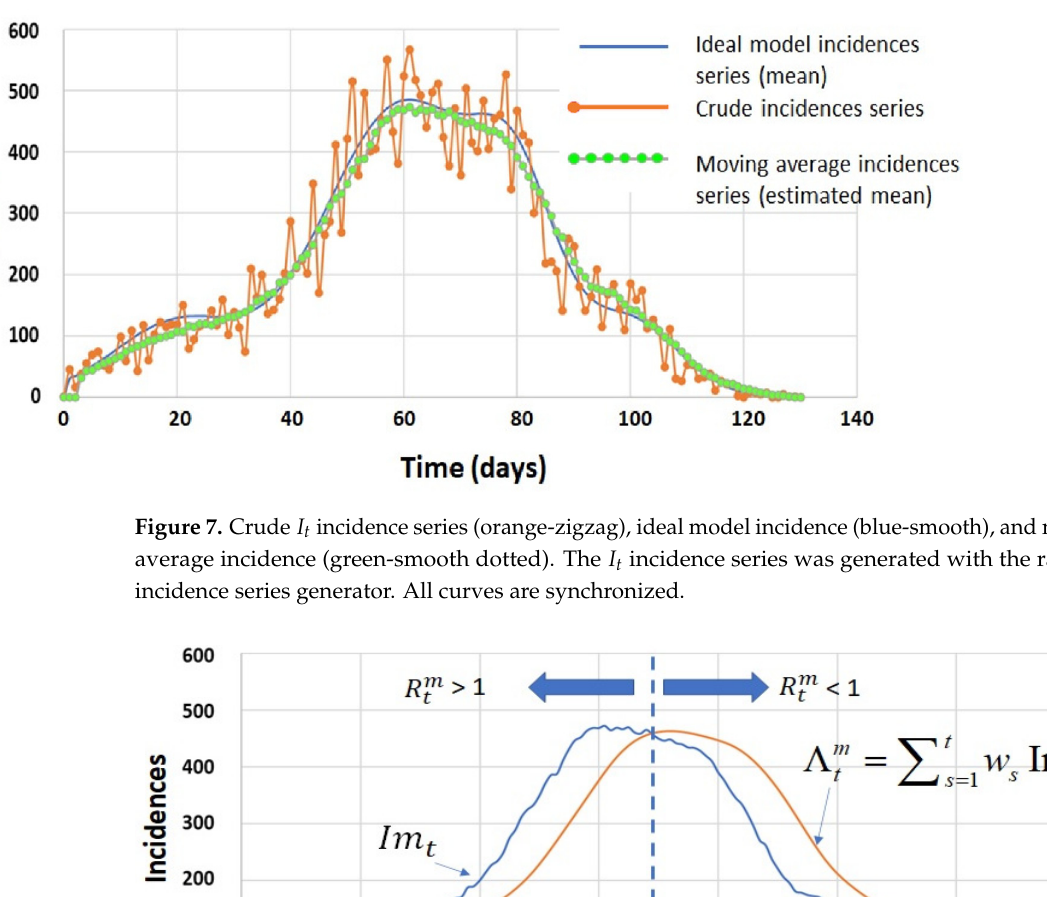
Figure 9. Comparison between reproduction number curves, 𝑅 (cid:3047)∗ , 𝑅 (cid:3047)(cid:3040) exact, and 𝑅 (cid:3047)(cid:3040) approx.